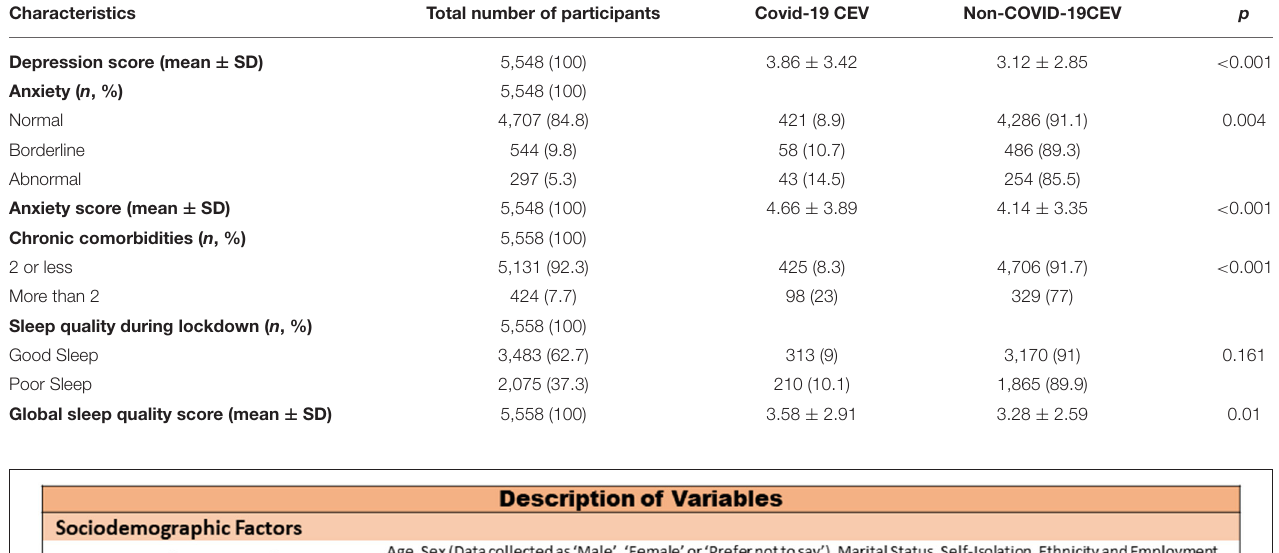
Overall, 9% of the cohort were CEV (523 out of 5,558). Comparisons between participants deemed high vs. low risk of COVID-19 complications revealed that those in the COVID- 19CEV group were more likely to be older, had higher depression and anxiety scale scores, as well as higher global PSQI-CCRR scores, indicative of poorer sleep quality ( Table 1 ). Similarly, the proportion of COVID-19CEV individuals was higher among males, smokers, those who drank less during lockdown